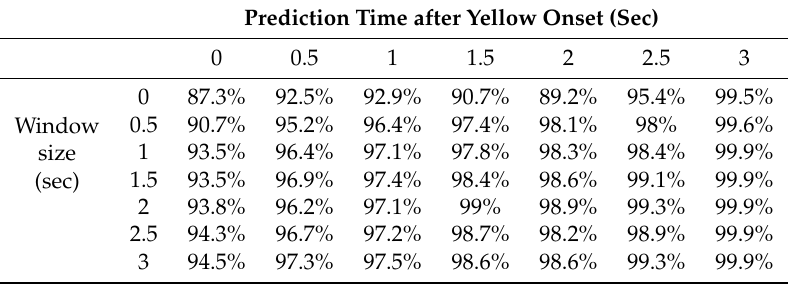
Classification accuracy of the Multi-Channel Deep Convolutional Neural Networks (MC-DCNN)